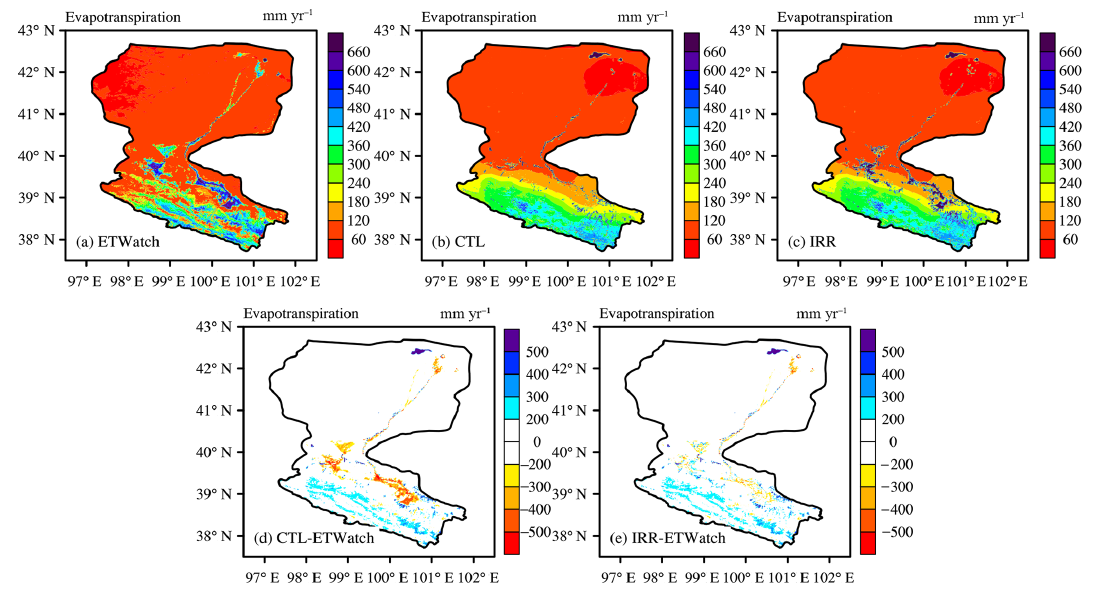
Figure 6. Climatological evapotranspiration distribution from 2000 to 2003 over the Heihe River basin obtained from (a) ETWatch, (b) CTL, (c) IRR, (d) CTL ETWatch, and (e) IRR